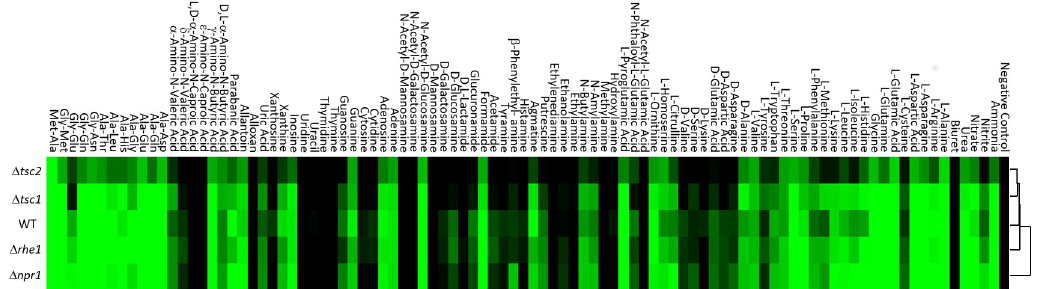
Fig 4. Comparative nitrogen source utilization profiles of T . atroviride Δ npr1 , Δ rhe2 , Δ tsc1 and Δ tsc2 mutants and the wild type. Hierarchical clustering of strains cultivated on 95 nitrogen sources and a control using the Biolog Phenotype PM3b nitrogen Microarray system at 25˚C for 72 hours. Clustering was done using HCE 3.5 tool with Average Linkage (UPGMA) method implementing Euclidean Distance measure. Heat map represents the mycelial density measured at 600 nm using Tecan Sunrise plate reader with Magellan Tracker software. The color heat map from black to bright green codes for optical density ranging from 0.1 to 0.85.